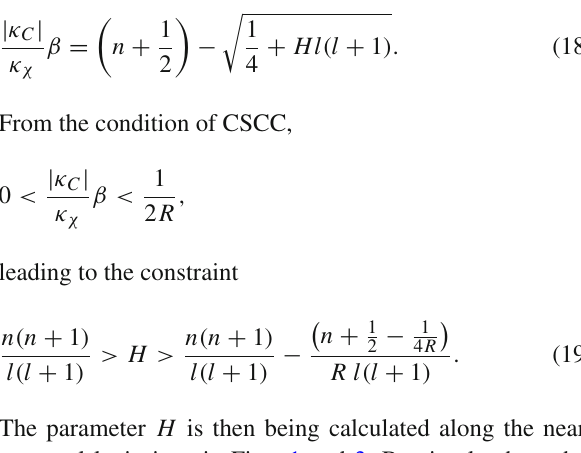
(cid:4) 0 . 1215 < H < 288